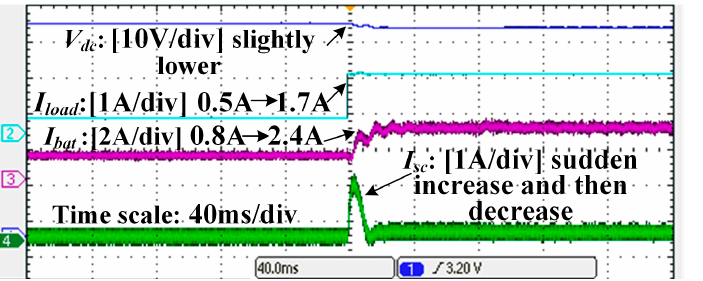
Figure 17. Control parameters of Group E: DC bus voltage, CPL current, battery current and SC